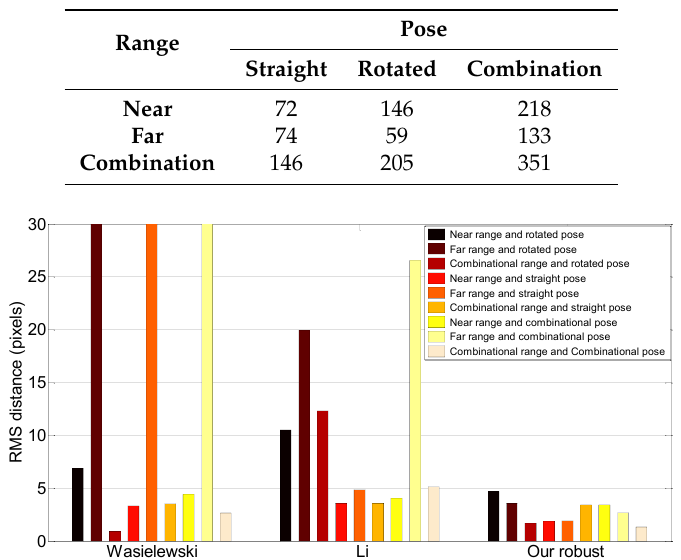
Figure 10. Line alignment error by the pose and range of the calibration target. Wasielewski’s method achieved over 100 pixel errors with the three far range pairs. Without these cases, Wasielewski’s method has an average of 3.75 pixel errors. The smallest line alignment error of our method is 1.32 pixels with the combination of range and